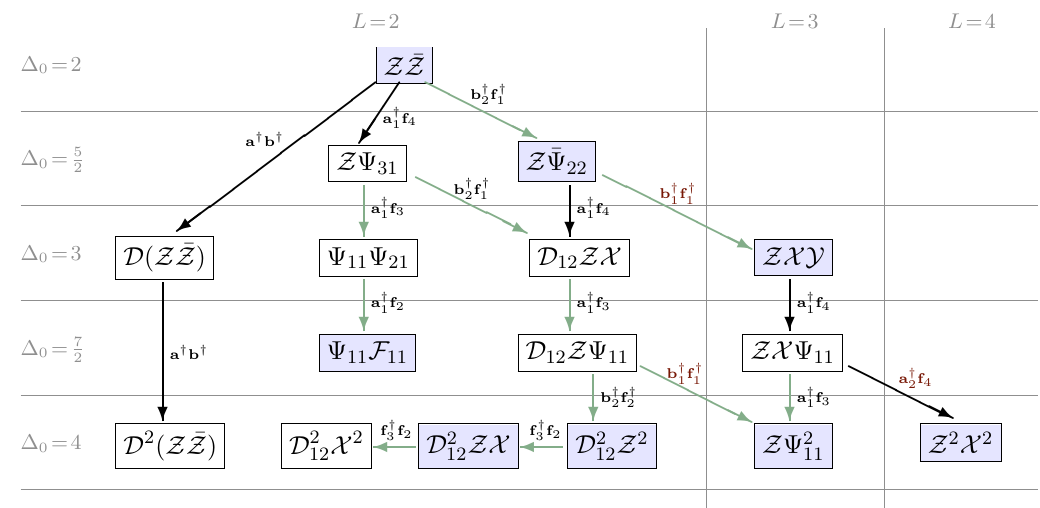
Figure 3 . Sample operators from the Konishi multiplet. Black arrows correspond to symmetries that remain in the (cid:12) -deformed theory, while the green arrows correspond to broken symmetries. Oscillators marked in brown indicate that it is the quantum corrected version of the corresponding generator that connects the two operators. Note that the given states are not the exact eigenstates, but just a sample of the (cid:12)eld content that they can contain. The highlighted operators correspond to the examples that we treat in this paper, see table